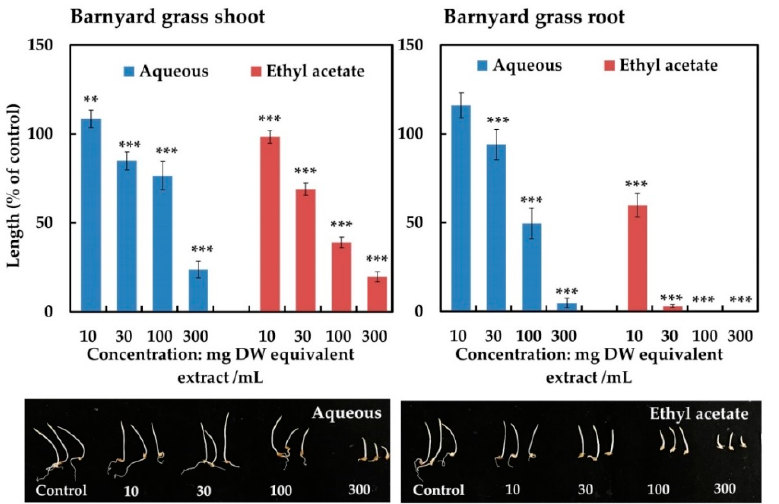
Figure 3. The inhibitory effect of the aqueous and ethyl acetate fractions obtained from Marsdenia tenacissima on the shoot and root growth of barnyard grass. The treatment concentrations were 10, 30, 100, and 300 mg DW equivalent extract/mL. The bars on each experiment express mean ± SE from three replicates, each with 10 seedlings ( n = 30). Asterisks indicate significant difference between control and treatment: ** p < 0.01, *** p < 0.001.